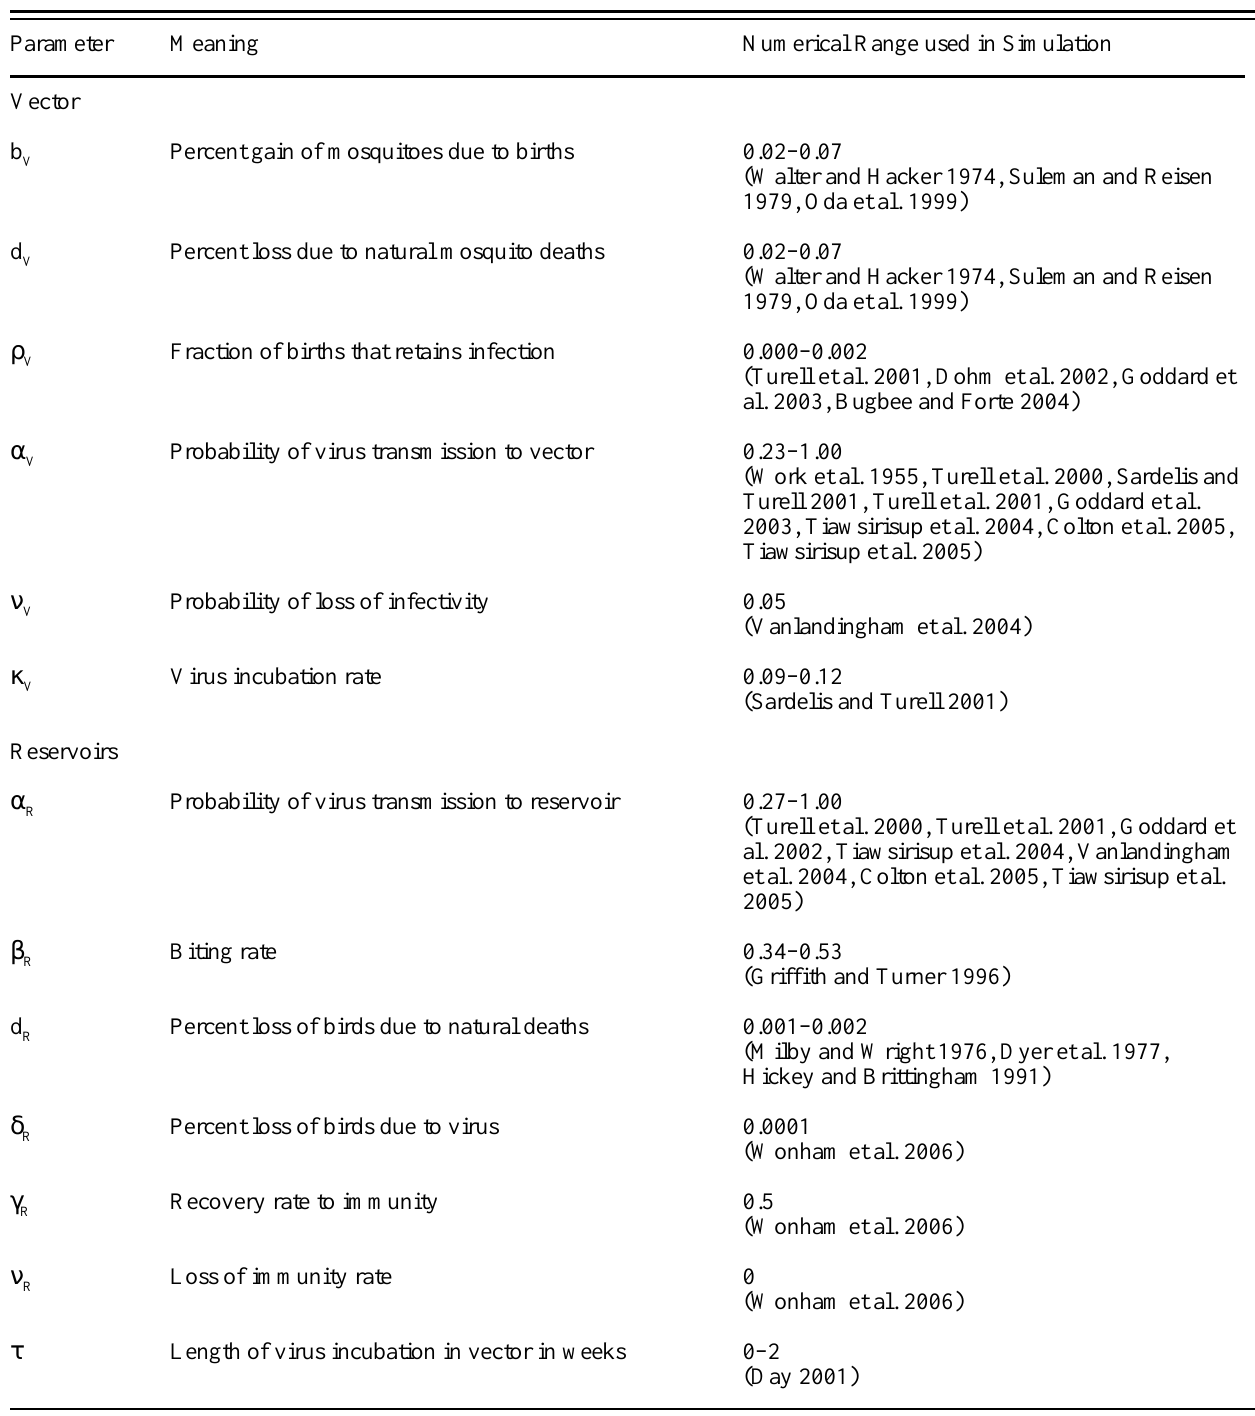
Table 3. List of parameters, meanings, and numerical ranges used to simulate the temperature-dependent delay differential equation West Nile model. All of the rate parameters are measured in units